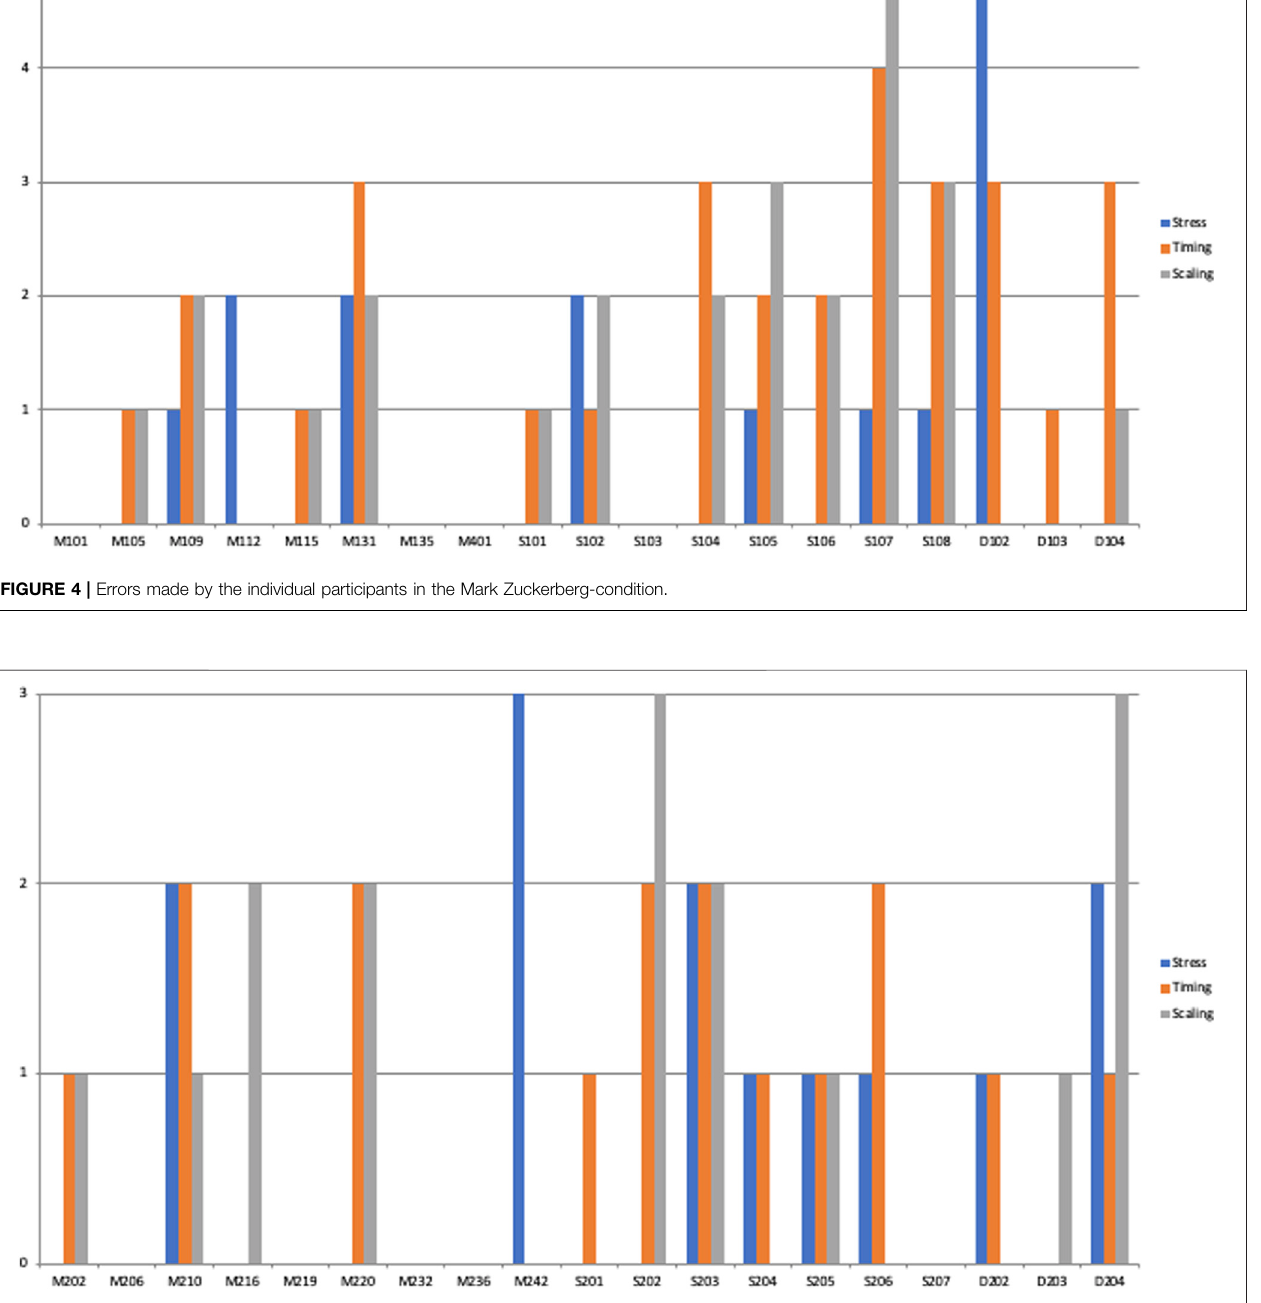
FIGURE 5 | Distribution of errors by participants in the Steve